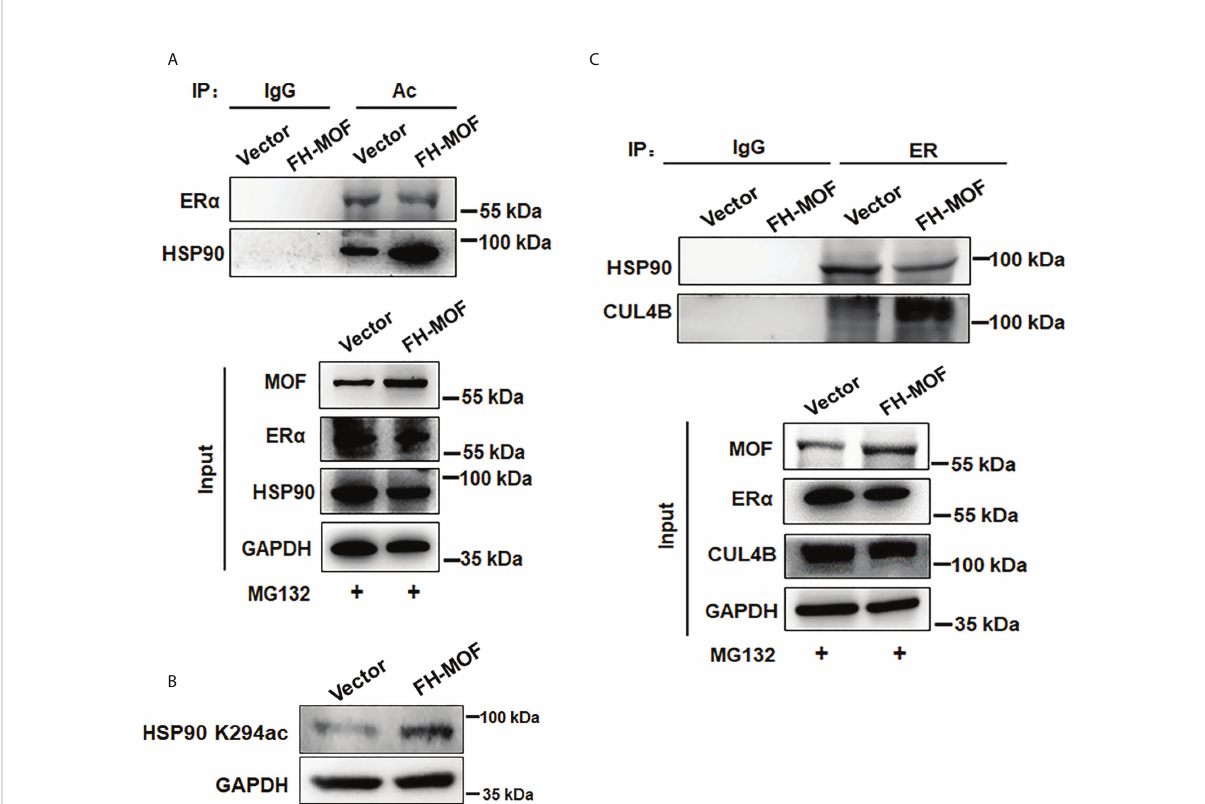
FIGURE 6 MOF promotes HSP90 hyperacetylation to inhibit its chaperon association with ER a . (A) The acetylation level of ER a and HSP90 was investigated by Co-IP using acetylated lysine antibody for IP and antibodies against ER a and HSP90 for Western blotting in FH-MOF – transfected MCF7 cells. (B) HSP90 K294 acetylation site was identi fi ed to be functioning in MOF-induced hyperacetylation of HSP90 by Western blotting assay using speci fi c HSP90 K294ac antibody. (C) MOF overexpression enhanced the protein interaction between ER a and CUL4B but undermined the chaperon association of HSP90 with ER a in Co-IP